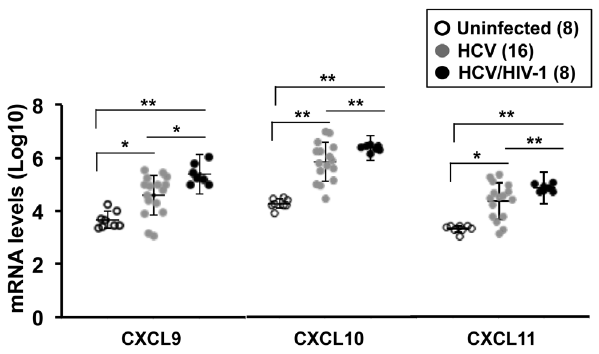
Figure 2. Intrahepatic mRNA levels of CXCR-3-associated chemokines in individuals infected or uninfected with HCV or HCV/HIV-1. Chemokine mRNA levels were measured by qPCR assays. Plasmid constructs containing either partial CXCL9, CXCL10, or CXCL11 gene were used to establish standard curves in each qPCR performance for quantitative analysis of CXCL9, CXCL10, or CXCL11 cDNA copy number. Plasmid DNA concentrations were determined using a ND- 1000 UV–vis Spectrophotometer (NanoDrop Technologies, Wilmington, DE). The number of construct copies in the plasmid solution was calculated, based on plasmid vector size (pCR2.1-TOPO, 3931 bp, Invitrogen, Carlsbad, CA) and insert size of CXCL9, CXCL10, or CXCL11 gene fragment, respectively. A plasmid-based calibration curve was generated with 10-fold serial dilutions of plasmid containing the CXCL9, CXCL10, or CXCL11 gene fragment sequence; to control pipetting